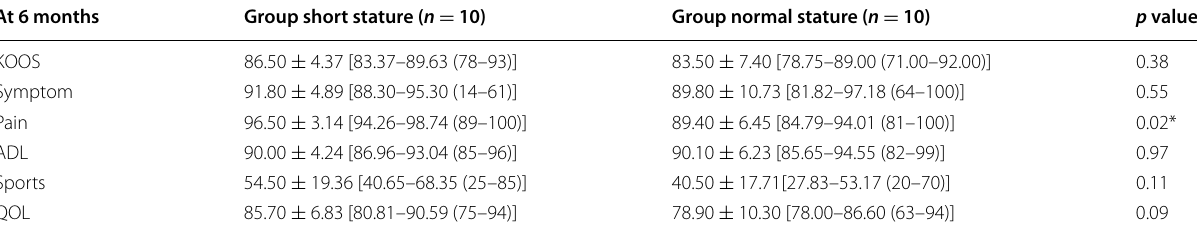
Table 4 Knee Injury and Osteoarthritis Outcome Score (KOOS) and subtypes in patients of short versus normal stature at 6 months following total knee